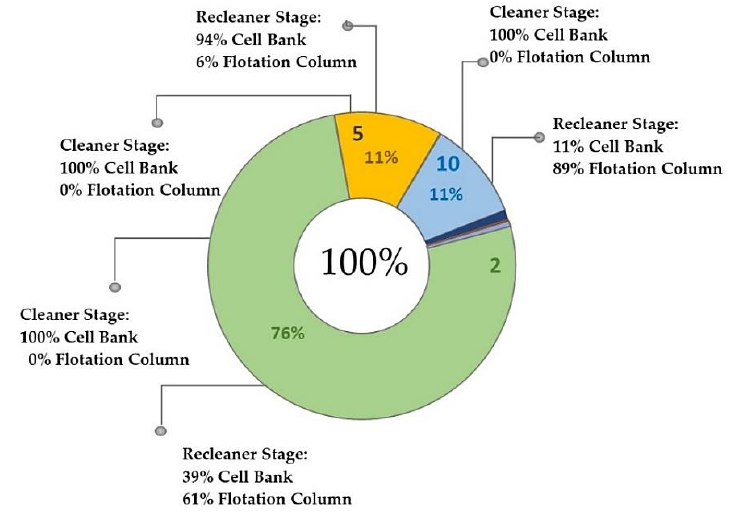
Figure 8. Graphical representation of the percentage of optimal structures considering the selection of equipment in cleaner and recleaner stages, with copper price uncertainty described by U(5000,7000).